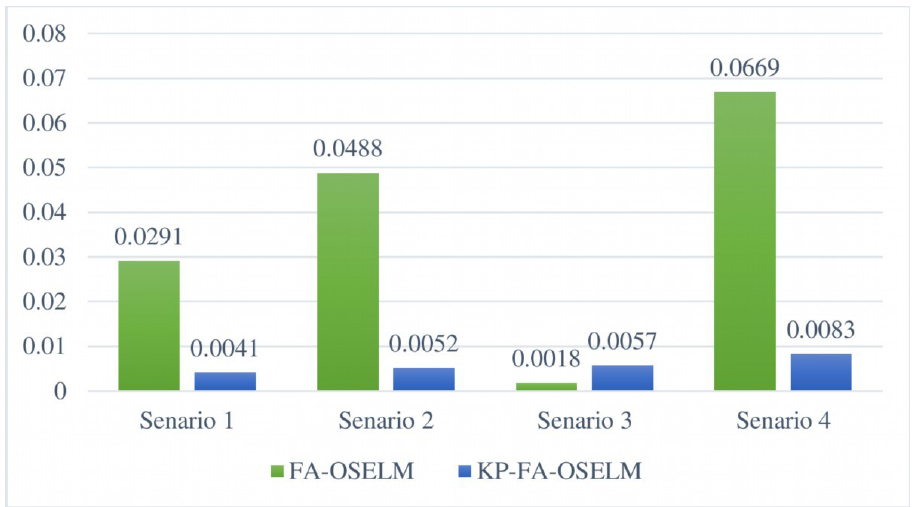
Figure 11. Standard deviations of model signal accuracy obtained using MFA-OSELM and FA-OSELM for the TampereU dataset.